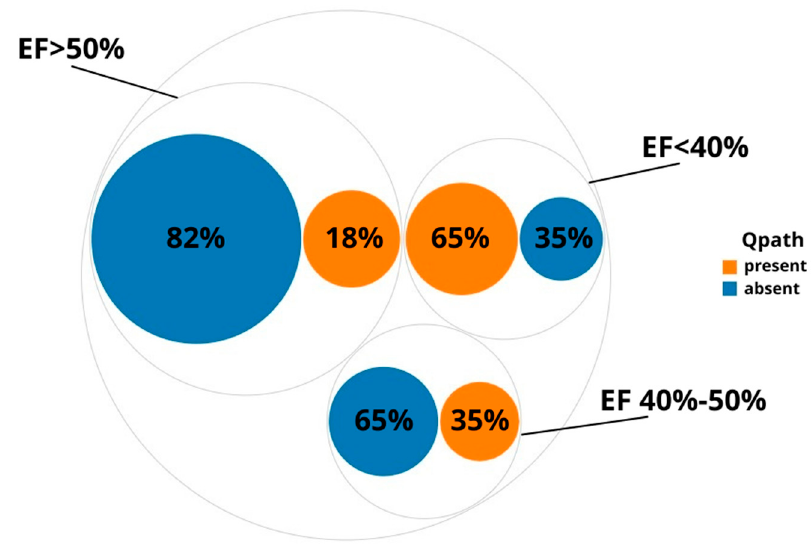
Figure 6. The occurrence of pathological Q wave in the groups under study; Qpath—pathological Q wave.